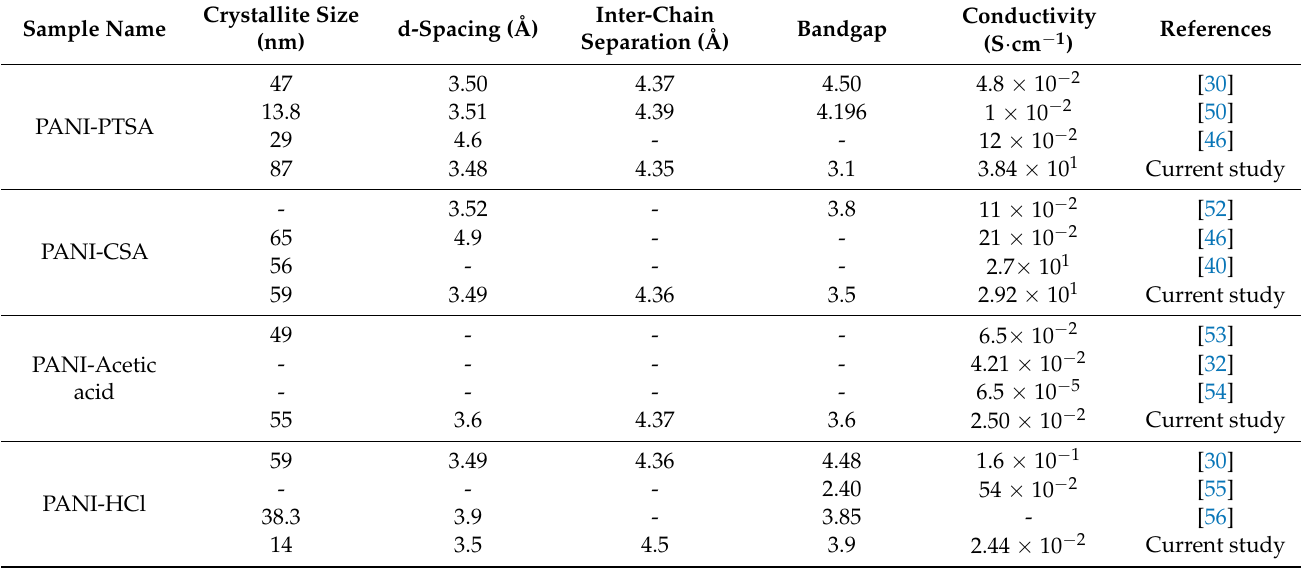
Table 5. Features of synthesized PANI samples and comparison with other research.